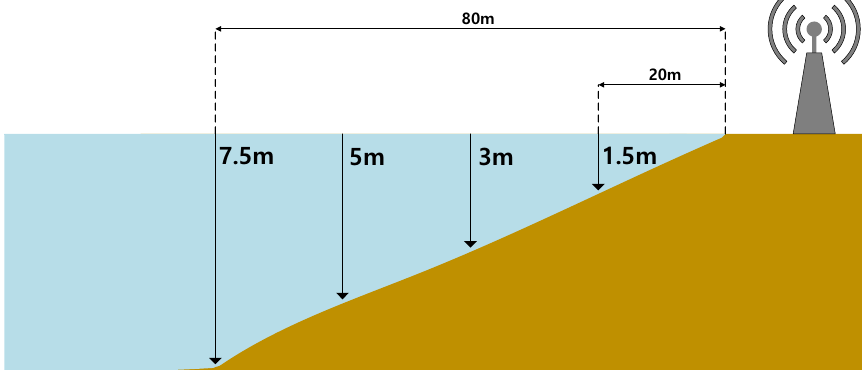
Figure 6. The water depth modeling for the performance evaluation.